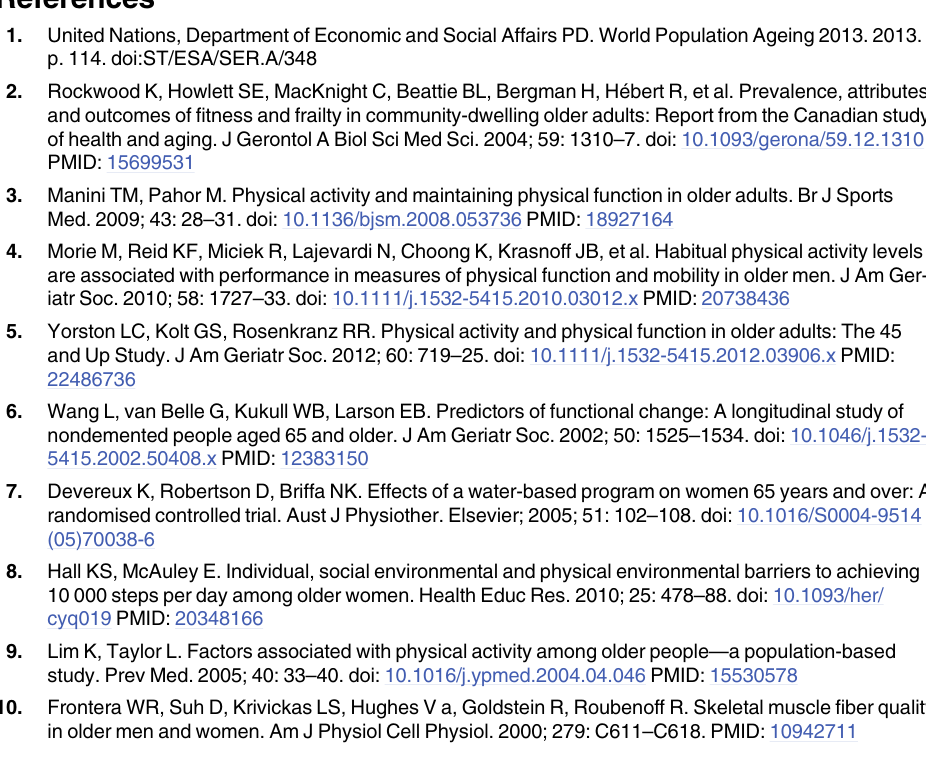
S1 Table. Main and two-way interaction effects on self-reported transport walking and rec- reational walking (first step of the analyses). S2 Table. Multivariable model for recreational walking. S3 Table. Main, two- and three-way interaction effects on objectively-measured MVPA (first step of the